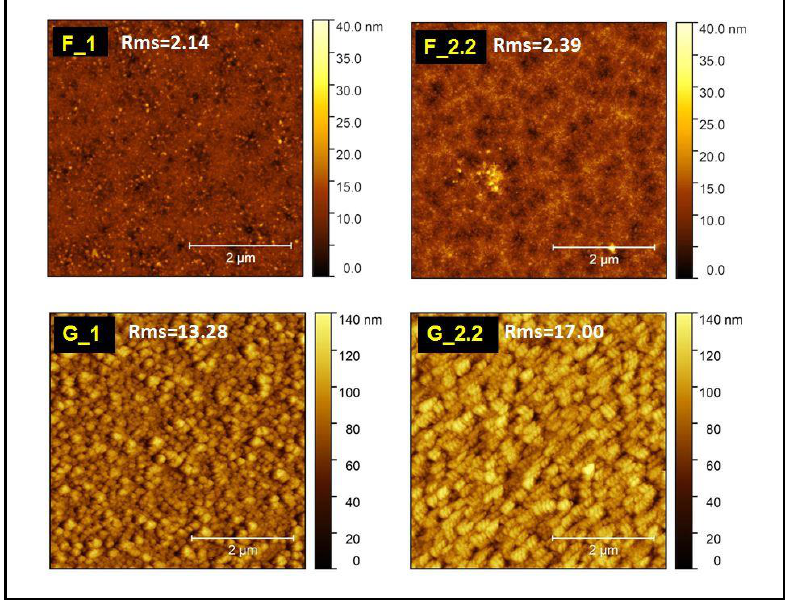
Figure 4. 2D AFM images and the average RMS surface roughness of ( a ) F_1, ( b ) F_2.2, ( z scale: 0 – 40 nm) ( c ) G_1 and ( d ) G_2.2 ( z scale: 0 – 140 nm); films all shown in an x – y scale of 5 μm × 5 μm .